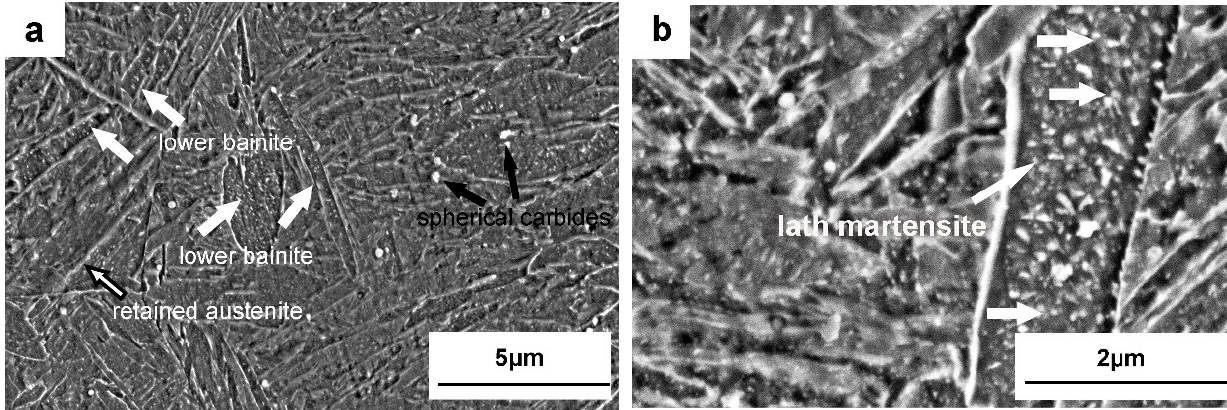
Figure 1. Microstructures of the Dievar steel after oil-quenching at 1030 °C, shown at different magnifications: ( a ) 15,000×, ( b ) 35,000×.